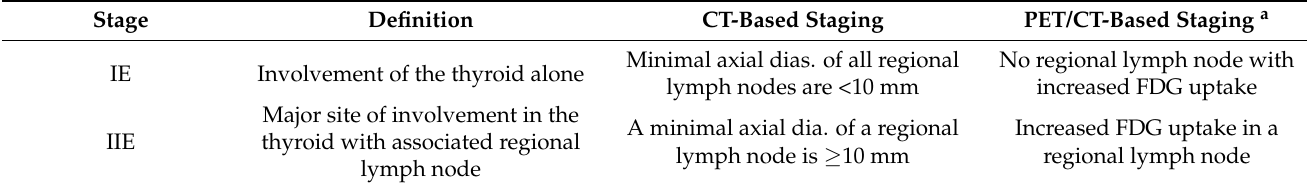
Table 1. Modified staging system for primary thyroid MALT lymphoma: The Tokyo